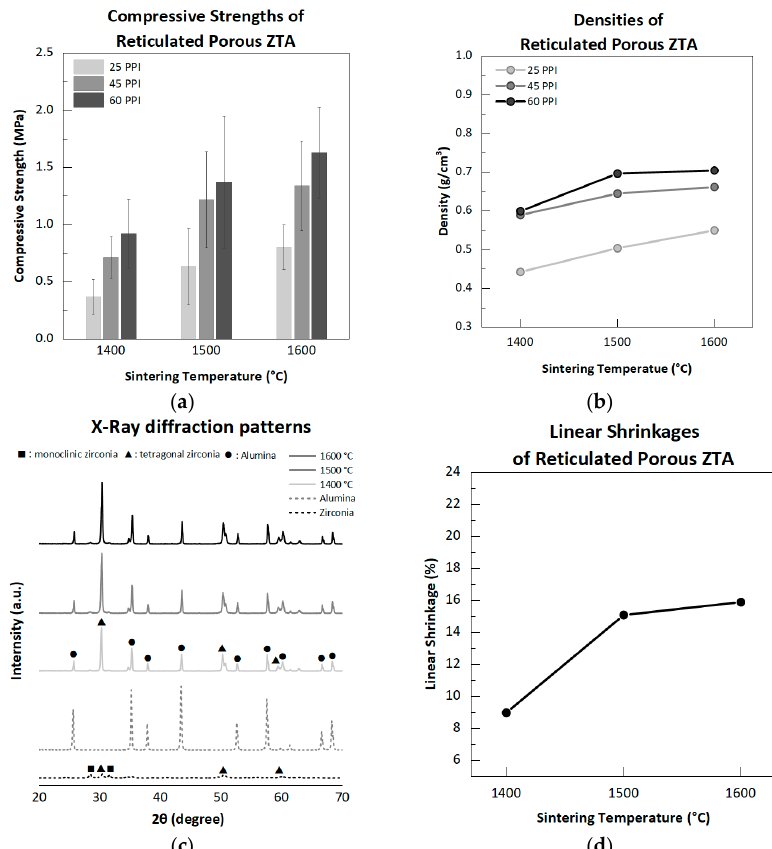
Figure 4. ( a ) Compressive strength outcomes of the reticulated porous ZTA specimens prepared from coarse zirconia particles sintered at 1400–1600 °C, ( b ) densities, ( c ) X-ray diffraction patterns of reticulated porous ZTA with different sintering temperatures, and ( d ) linear shrinkage rates.